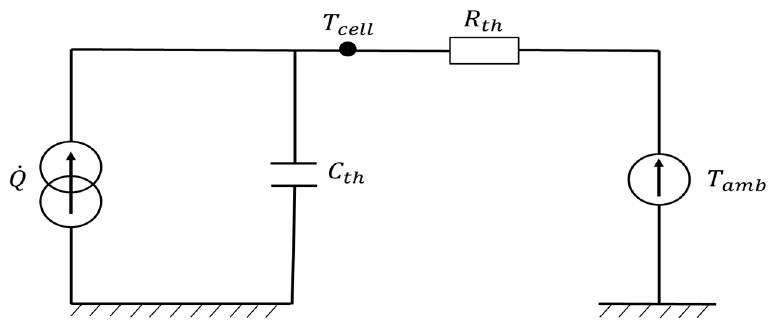
Figure 3. Battery thermal model.